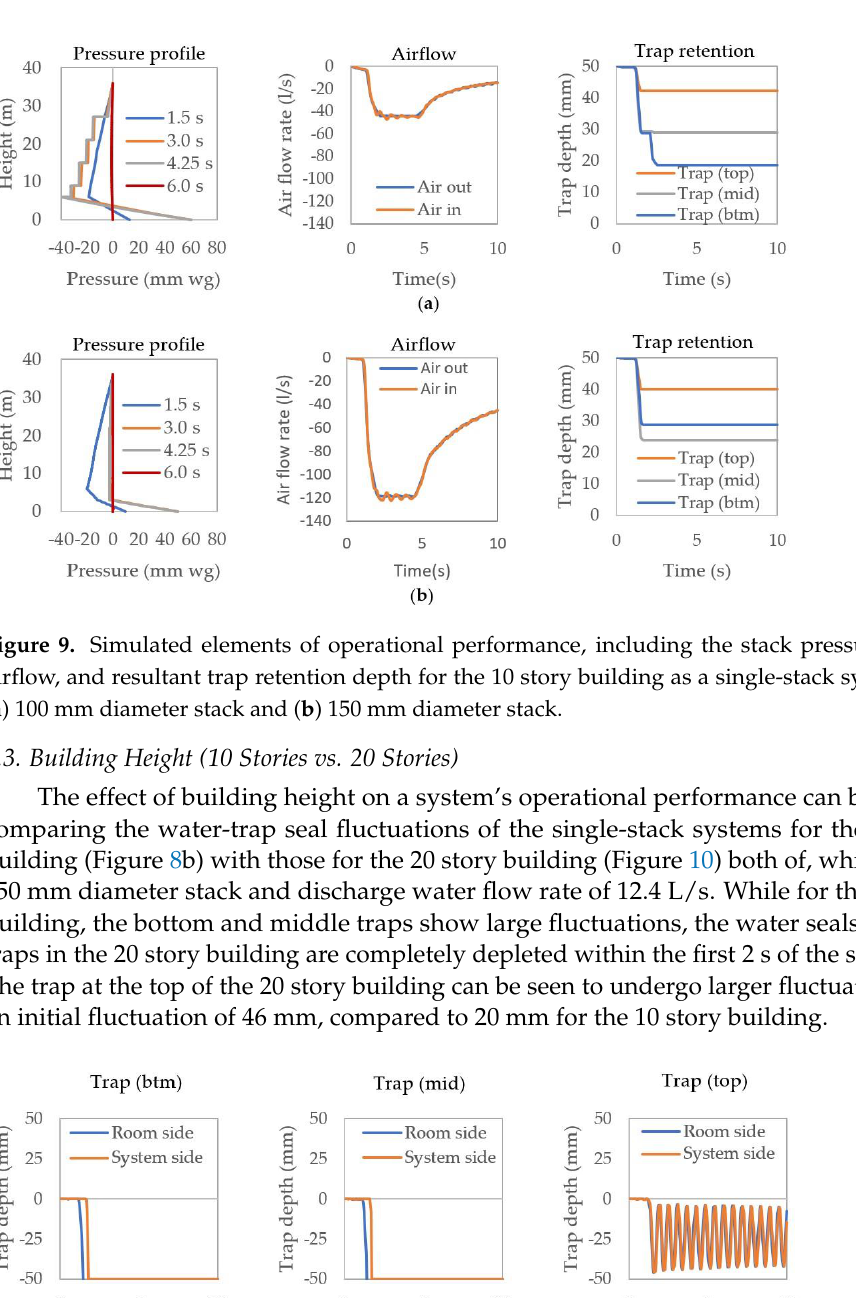
Figure 10. Simulated water-trap seal fluctuations for the 20 story building as a single-stack sysTable 150 mm diameter